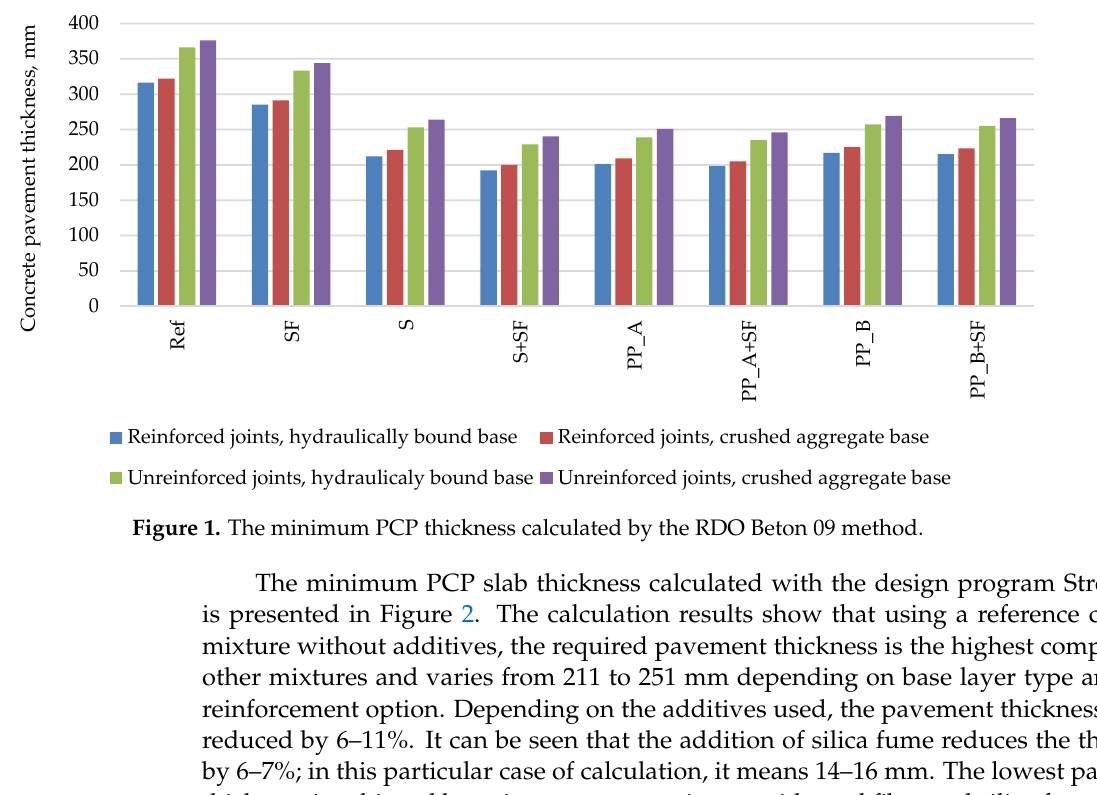
Figure 1. The minimum PCP thickness calculated by the RDO Beton 09 method.